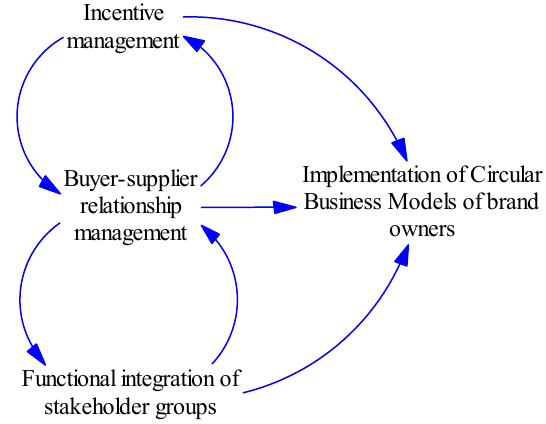
Figure 1. Causal loop diagram on supplier tactics (theory).